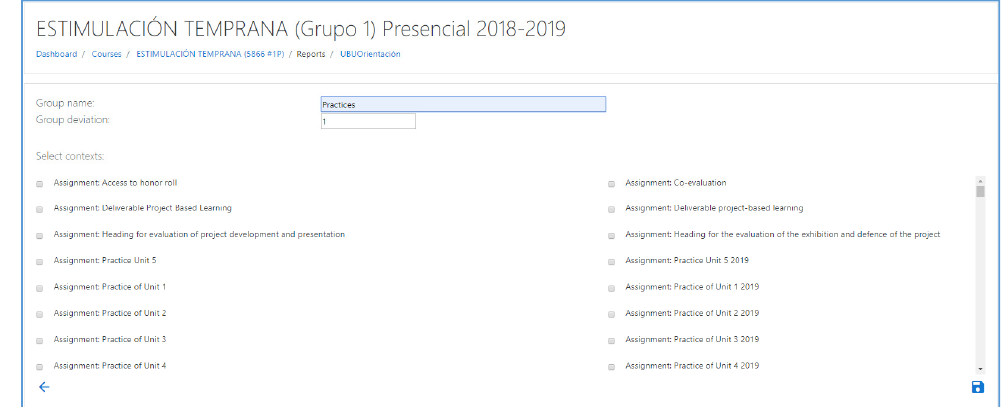
Figure 3. Example of different course modules. In this case, select context, assignments: practice unit.